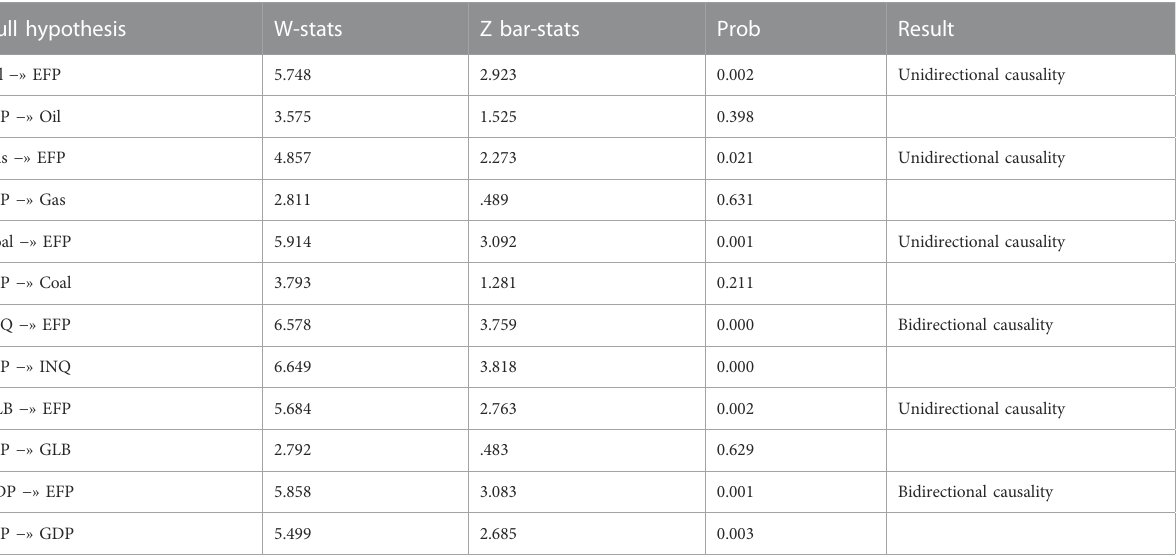
TABLE 6 DH causality